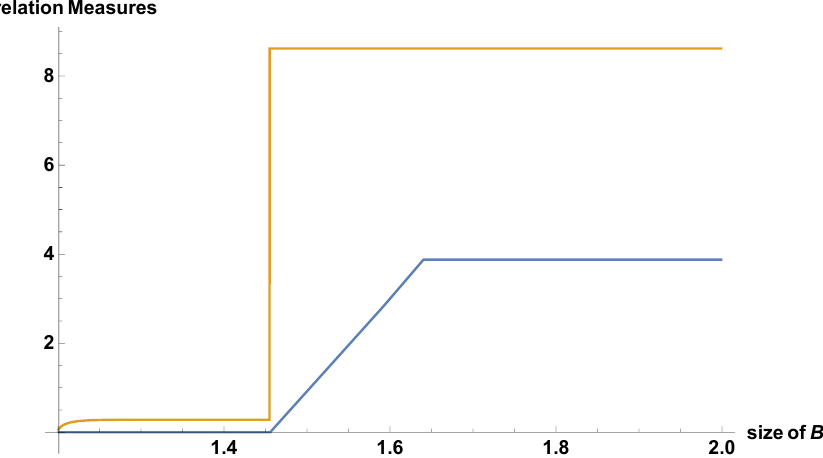
Figure 41 . Plot of correlation measures i.e. reflected entropy (yellow) and mutual information (blue) for two disjoint intervals A and B while the endpoint of the interval B is increased in the bath BCFT 2 s. In the y-axis, the correlation measures are plotted after scaling over the central charge c of the BCFT 2 s. Here r I = 1 , r O = 2 , (cid:15) = . 001 , β = . 1 , c = 500 , r 1 = 1 . 15 , r 2 = 1 . 2 , S bdyb = 875 and S bdya = 850